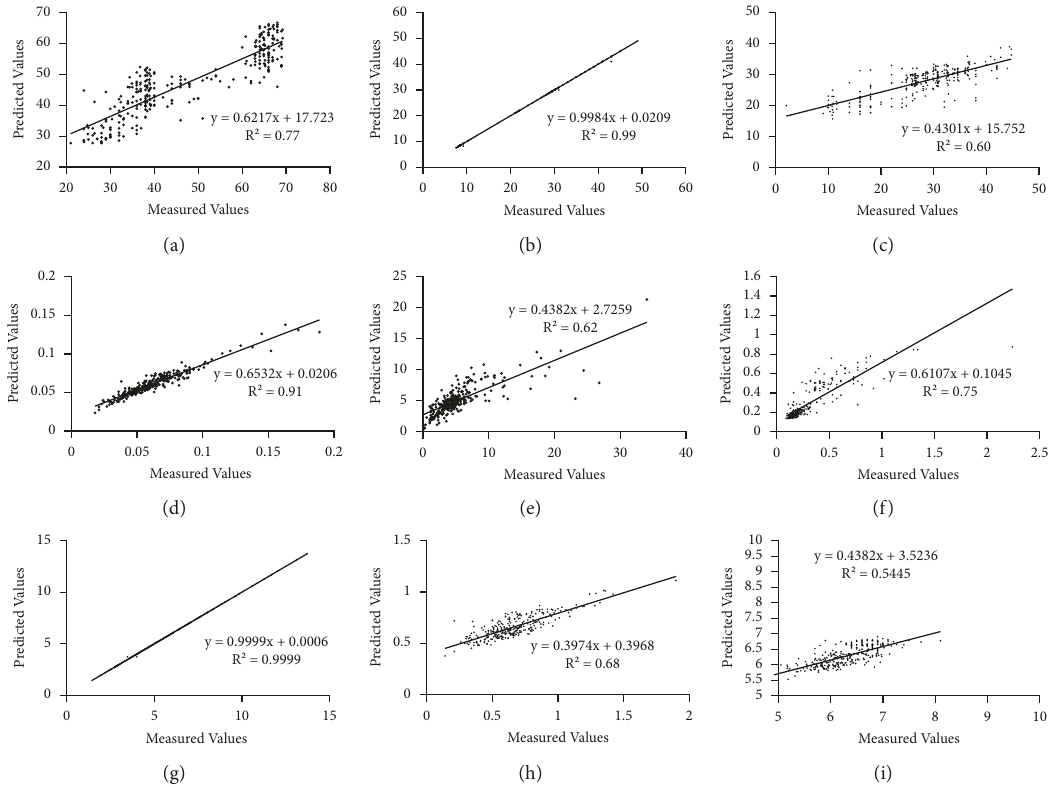
Figure 3: Relationship between measured and predicted values of the soil properties. ECEC pH potential (cid:28)